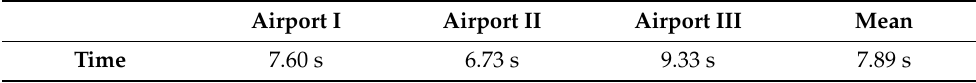
Table 9. Airport extraction time from SAR